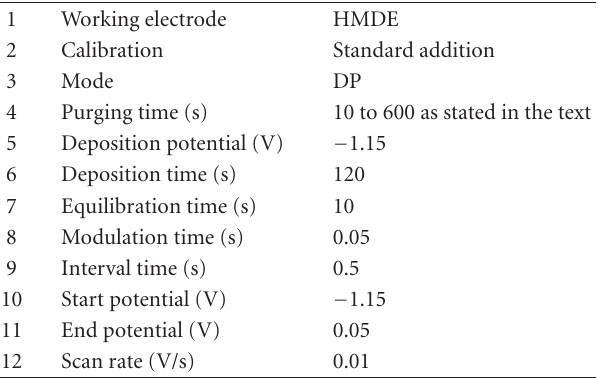
Table 1: Instrument operating parameters for simultaneous analy- sis of Zn(II), Cd(II), Pb(II), and Cu(II) in river water by di ff erential pulse